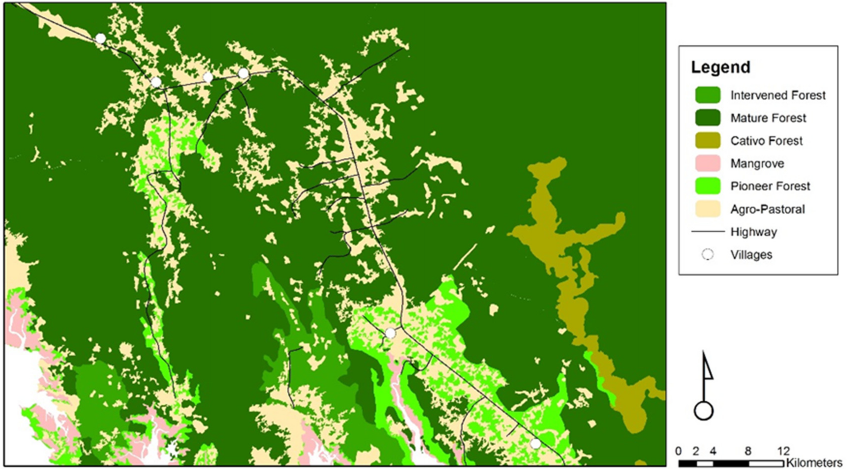
Figure 4. Land Cover in the Bayano ‐ Darién Region, 1990.